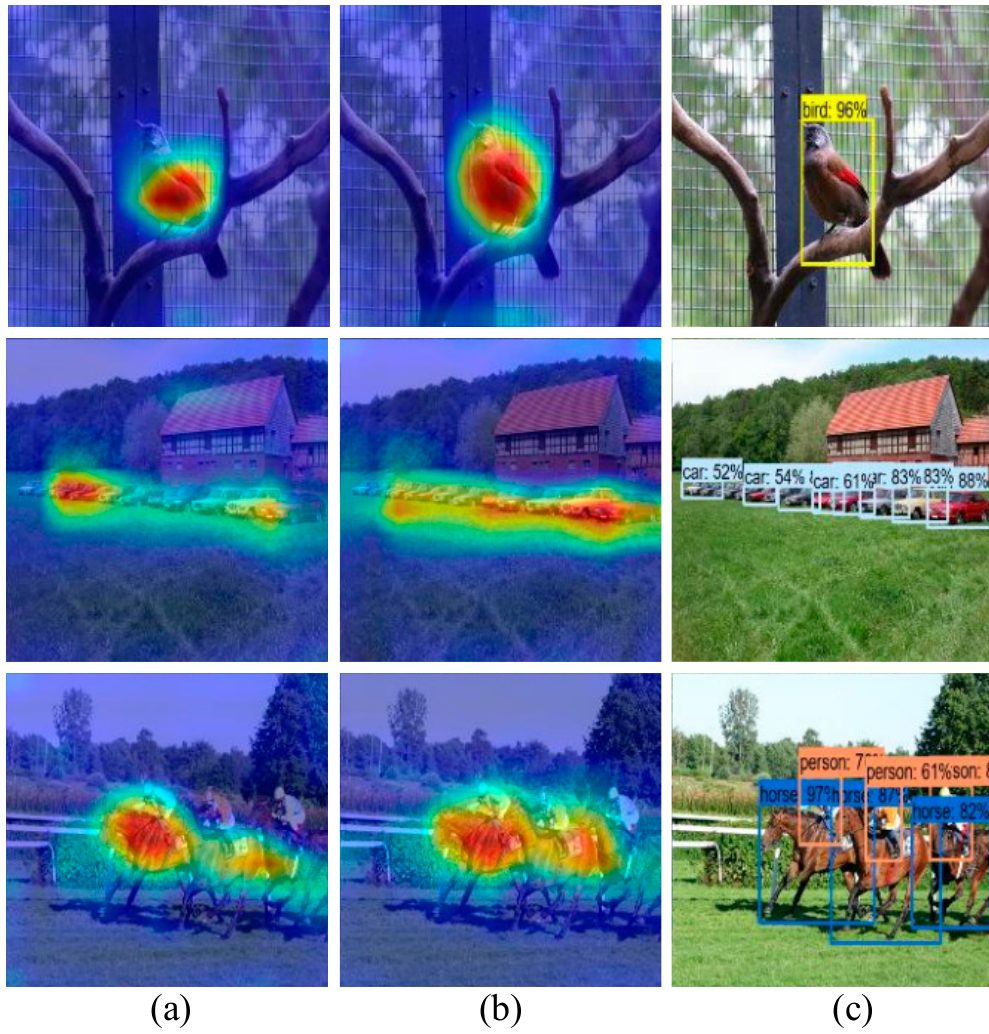
Figure 6. Visualization of attention maps on the PASCAL VOC 2007 test set: (a) Heatmaps of YOLOv3; (b) Heatmaps of GC-YOLOv3; (c) Detection effect diagrams of GC-YOLOv3.